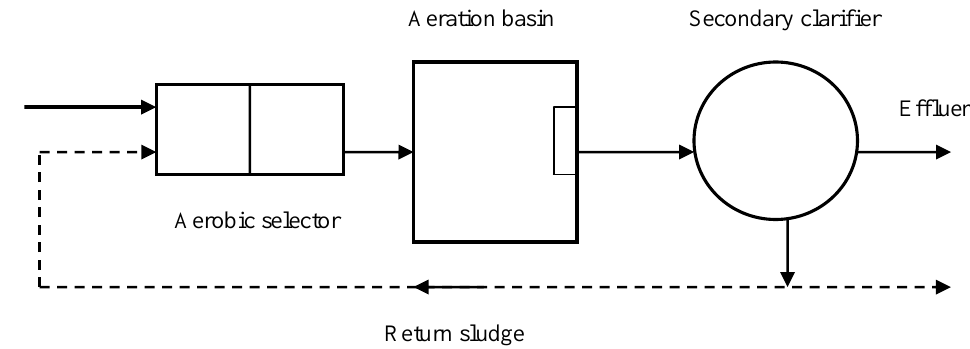
Fig. 10. Location of a biological selector in an activated sludge WWTP (Metcalf and Eddy Inc., 2003).